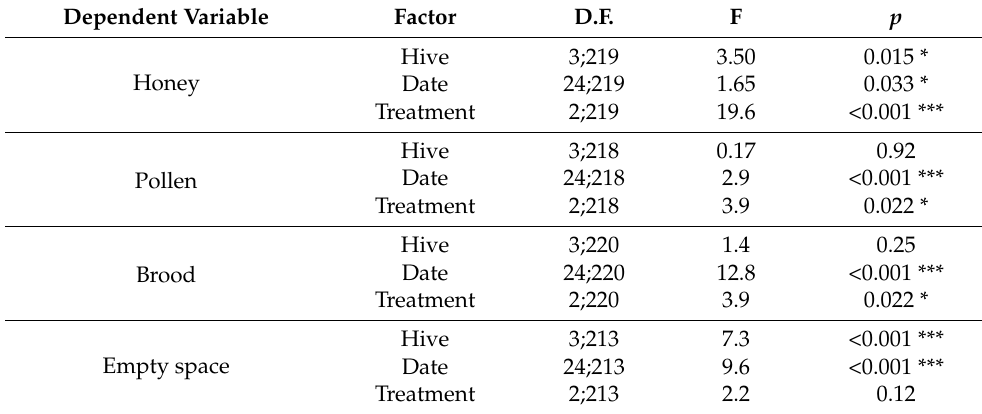
Figure 4. Box-plot chart of the honeycomb occupancy by honey, pollen, brood and empty space in the three experimental sites. Table 3. GLM analyses of honey, pollen, brood and empty space as dependent variables and “hive” “date” and “treatment” as factors: D.F. = degrees of freedom; F = Fisher’s value; p = probability of the null hypothesis.